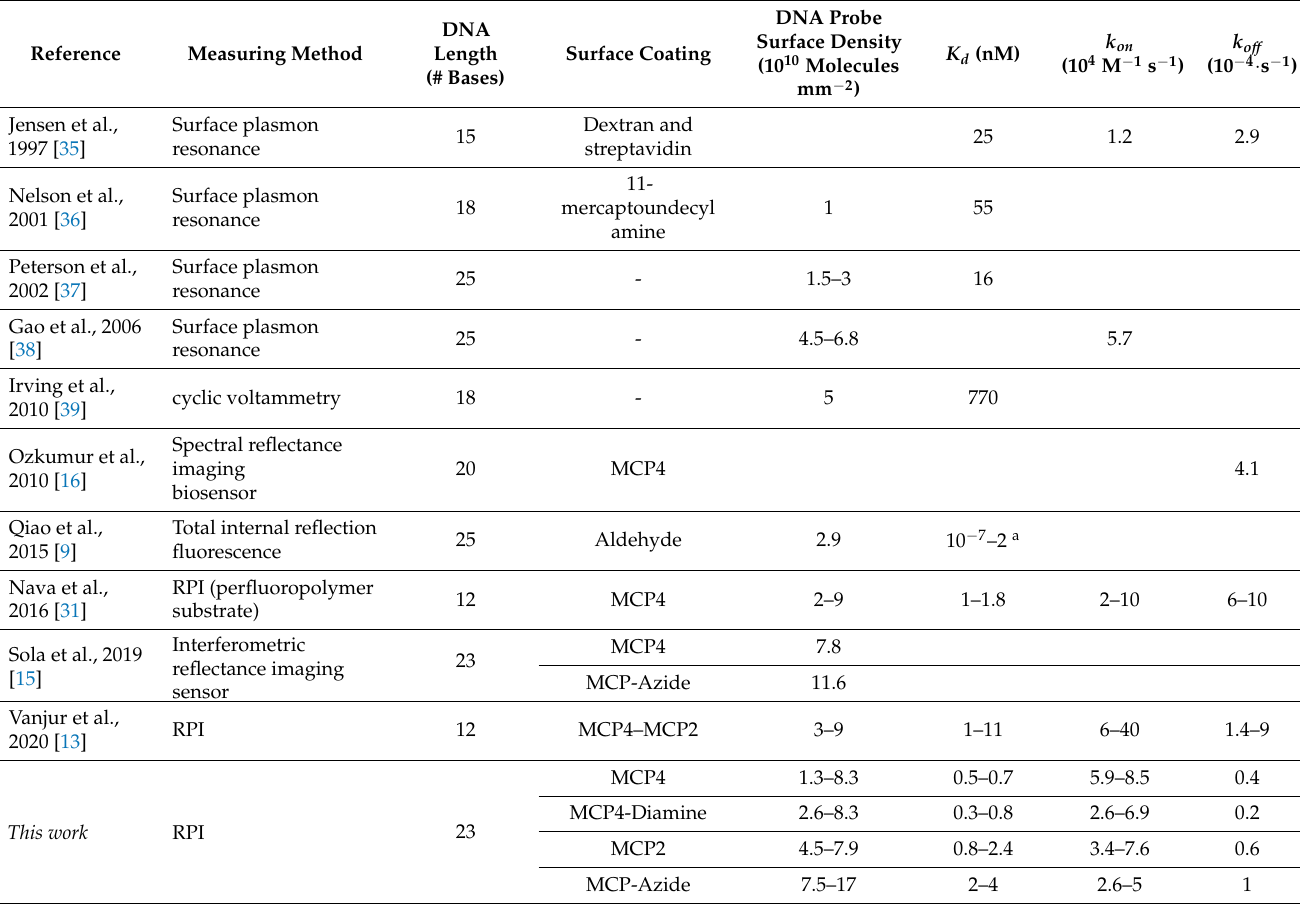
Table 1. Comparative table reporting examples of surface DNA hybridization